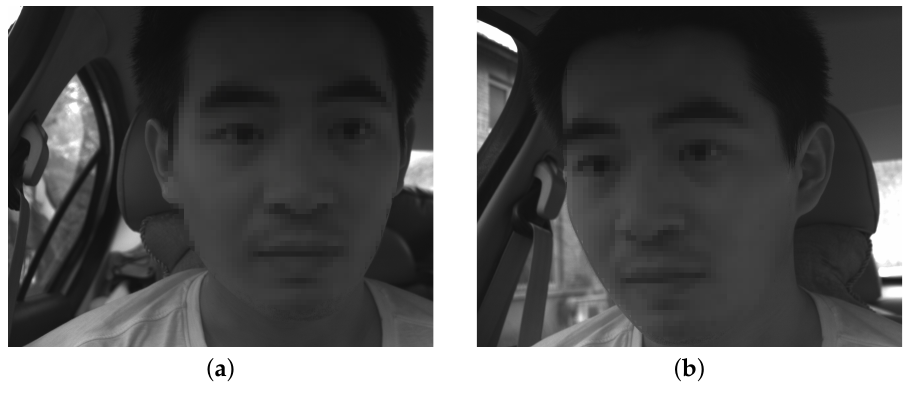
Figure 12. Facial images captured by binocular stereo video system: ( a ) left-hand camera; ( b ) right-hand